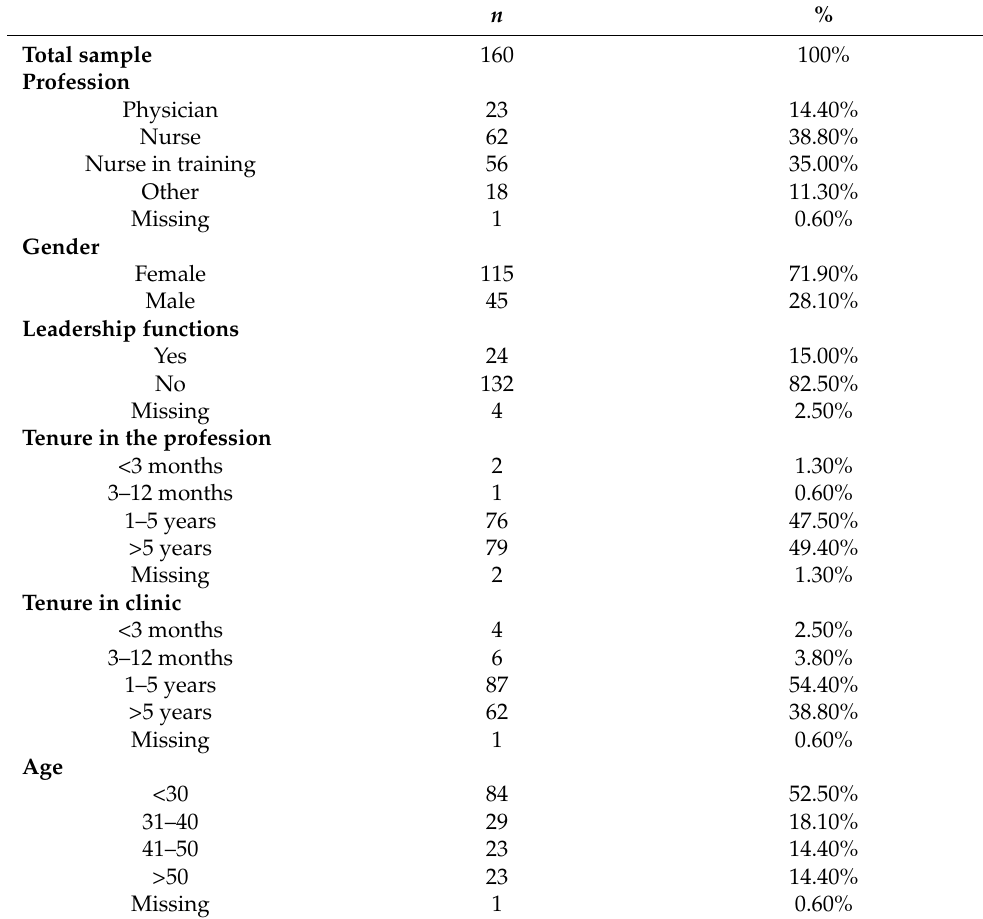
Table 1. Characteristics of the study